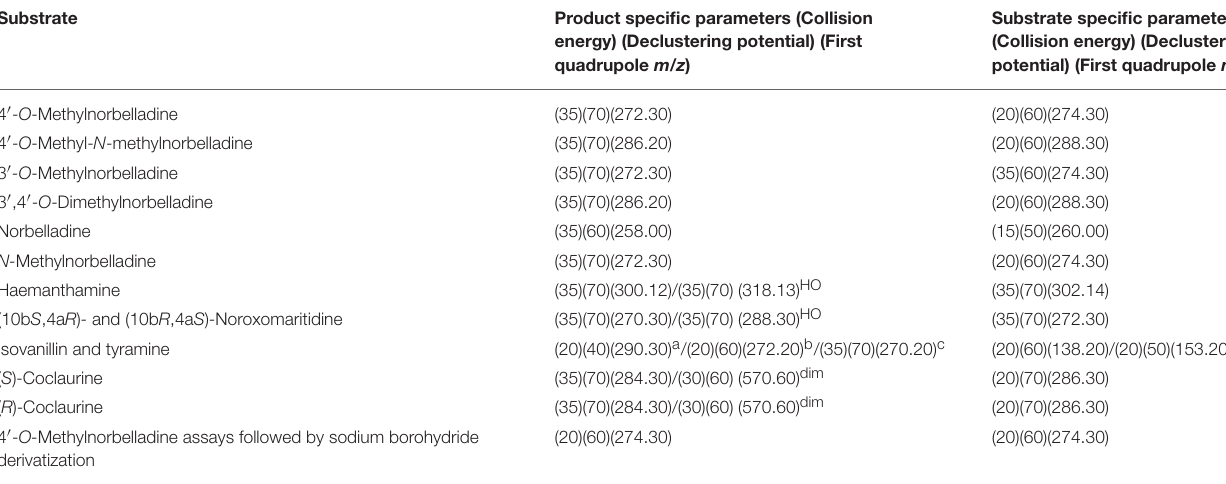
TABLE 2 | MS/MS parameters for substrate tests.